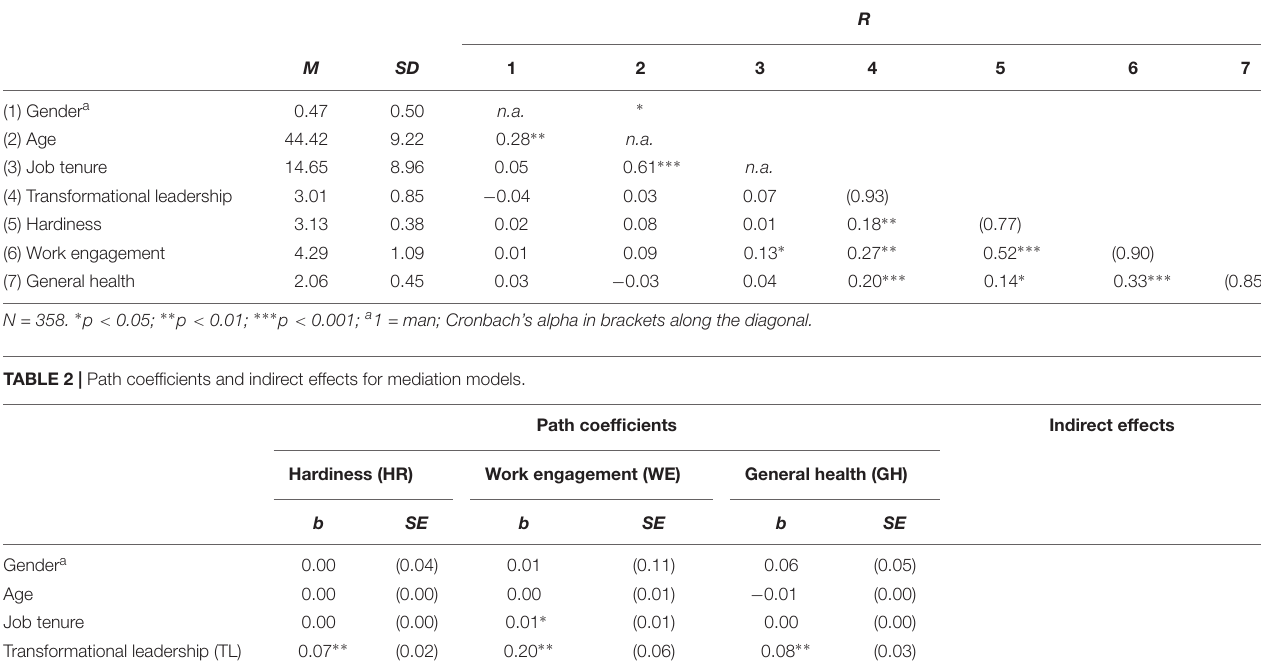
TABLE 1 | Mean, SD, and correlation among study variables.